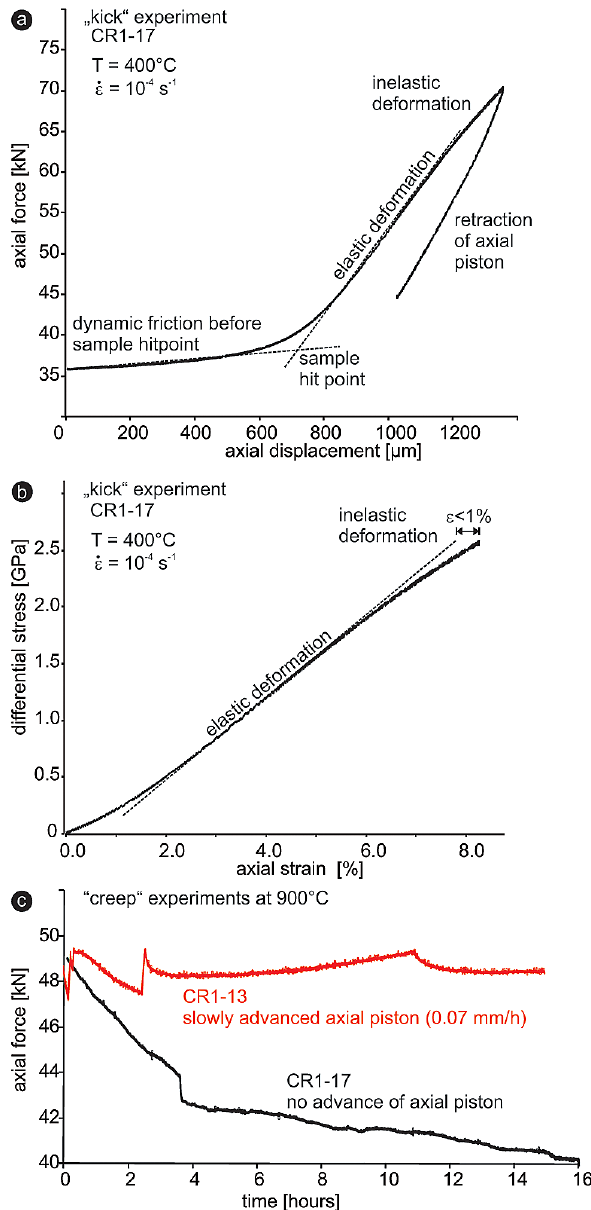
Fig. 2. (a) Selected force–time curve and (b) corresponding stress– strain curve for low-temperature, high-stress “kick” experiment CR1-3. (c) Selected force–time curves for high-temperature, low- stress (“creep”) stage in the experiments CR1-13 (stress kept ap- proximately constant by moving the piston into the sample assem- bly) and CR1-17 (stress relaxation, no active movement of